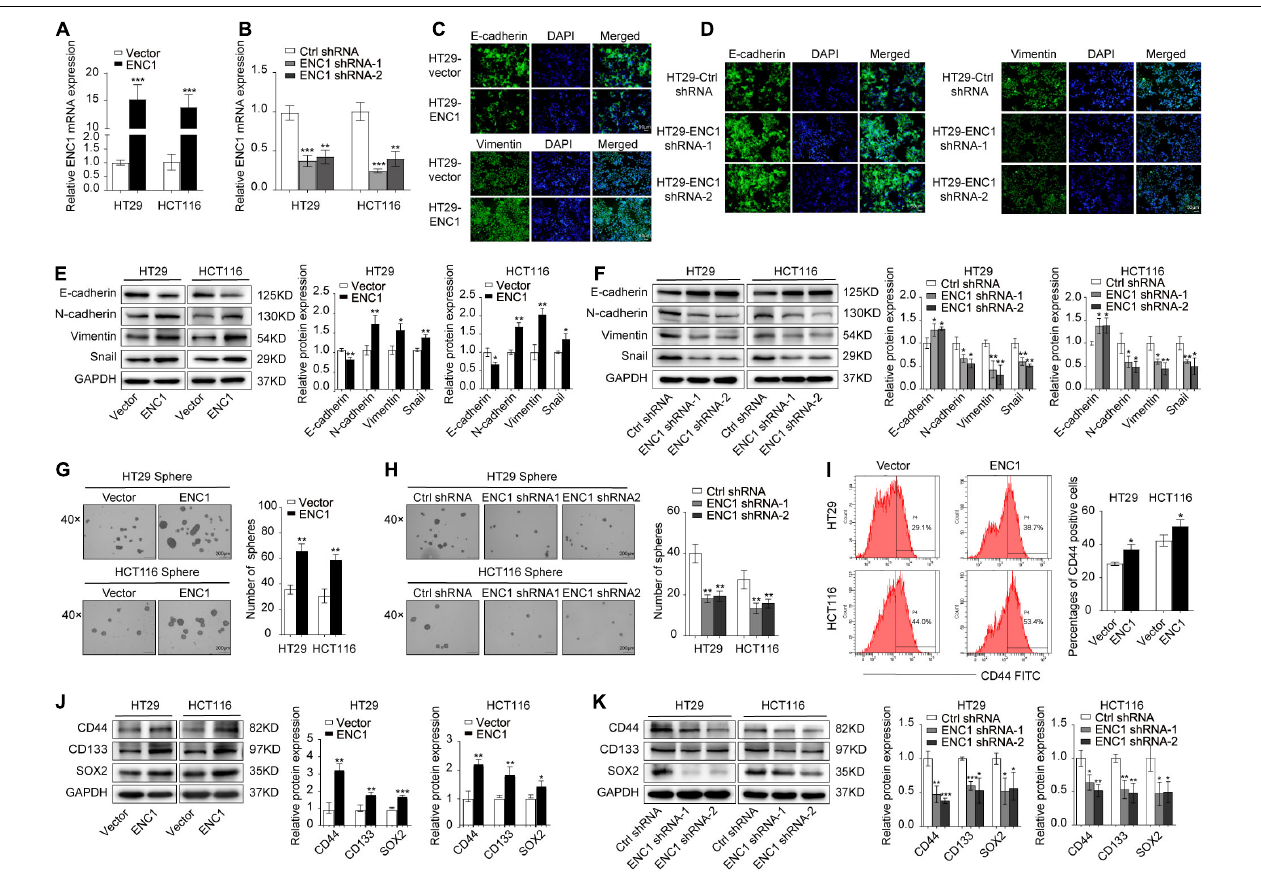
FIGURE 3 | ENC1 overexpression induces EMT and maintains stemness of CRC. (A,B) The ENC1 overexpression or knockdown efficiency was assessed in ENC1-overexpression and ENC1-knockdown HT29/HCT116 cells by qRT-PCR. (C,D) Immunofluorescence staining of E-cadherin and Vimentin expression in overexpressed or silenced HT29 (magnification × 20, scale bar = 50 µ m), and the cell nuclei were stained with DAPI in blue. (E,F) EMT markers of E-cadherin, N-cadherin, Vimentin, and Snail protein expression levels in ENC1-overexpression and ENC1-knockdown CRC cells were detected by Western blotting. Representative images of sphere formation and sphere number analysis were displayed (magnification × 40, scale bar = 200 µ m) in HT29/HCT116 after ENC1 overexpression (G) and ENC1 knockdown (H) . (I) Flow cytometry analysis of CD44-positive cells in the indicated groups of cells. (J,K) Western blotting analysis of stemness markers (CD44, CD133, and SOX2) expression in ENC1-overexpression and ENC1-knockdown CRC cells. Results are presented as the mean ± SD of three independent experiments. * P < 0.05, ** P < 0.01, and *** P <